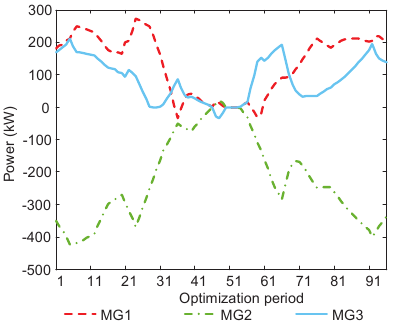
Figure 16. Decided exchange power among MGs on Day 2 of Scenario 1.